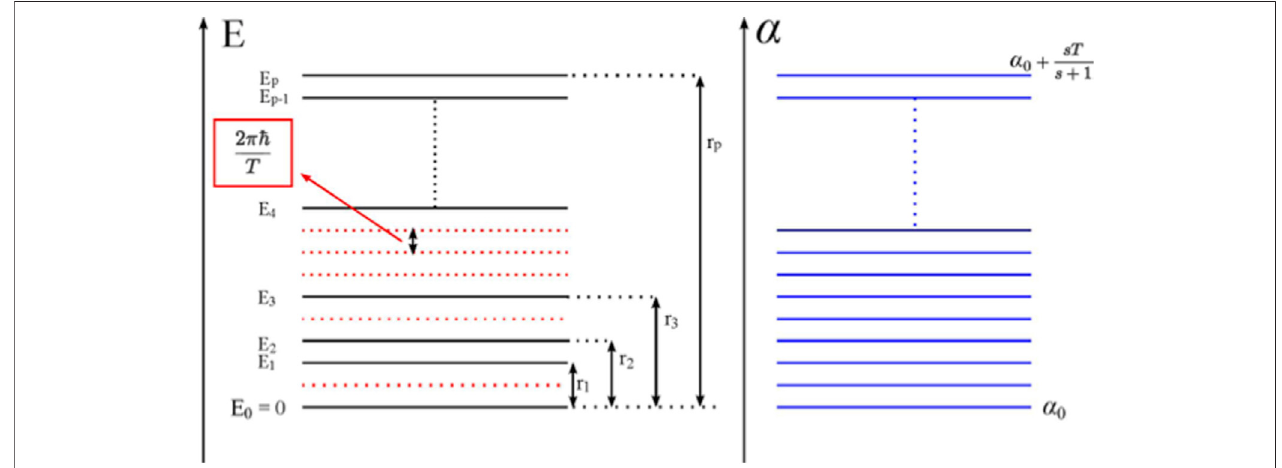
FIGURE 3 | Shows the distribution of the energy levels for unequal energy levels (left) and for equal ones